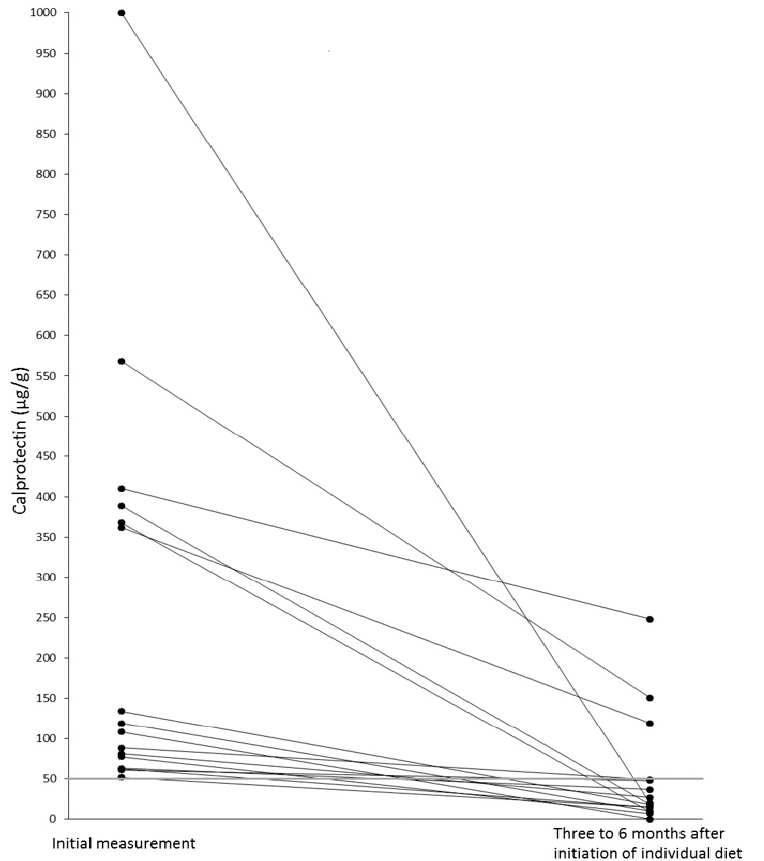
Figure 1. Reduction of elevated FCAL in 14 symptom-free patients with food intolerance/malabsorption after initiation of individualized diets. Improved symptoms in two patients with an initial diagnosis of LIT and a lactose-free diet. In these, a subsequent colonoscopy histologically diagnosed IBD.